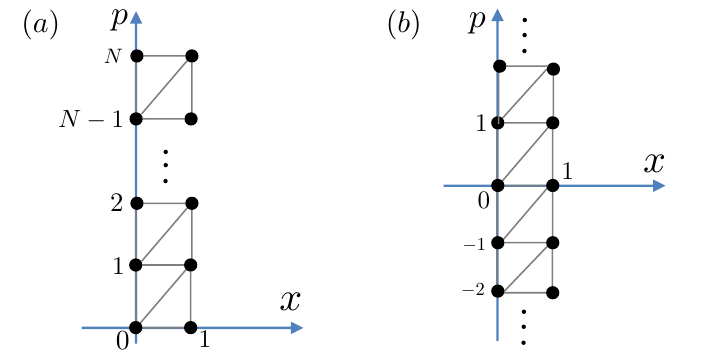
Figure 6 . The toric diagrams of the mirror curves in general case. The left panel corresponds to the N -chain geometry, and the right panel corresponds to the periodic N -chain